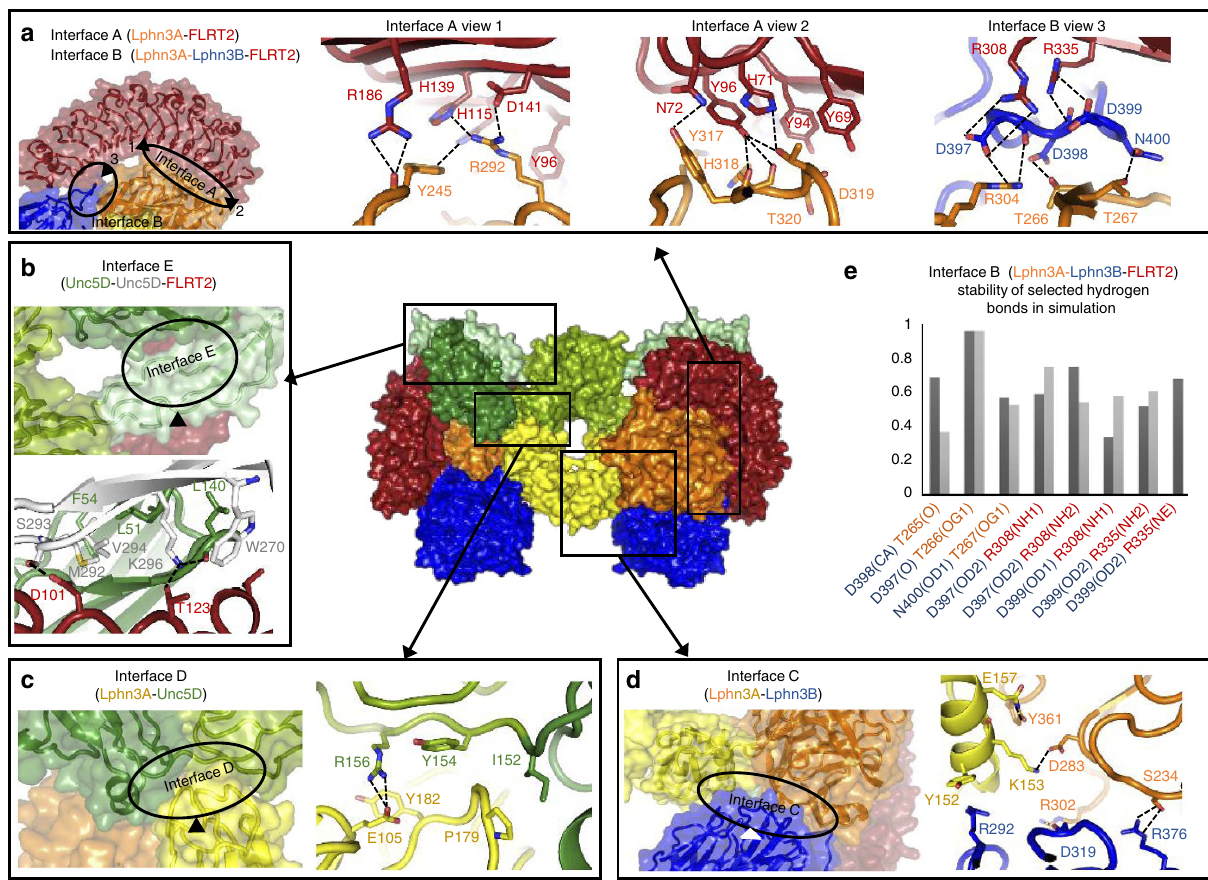
Figure 6 | Protein–protein interactions within the super-complex. ( a – d ) Novel protein–protein binding surfaces (interfaces A–E) in the FLRT2 LRR /Lphn3 Lec–Olf /Unc5D IgIgTSP complex are shown. Selected residues are shown as sticks. Selected putative hydrogen bonds are indicated as black dashed lines. ( e ) The stability of putative hydrogen bonds during molecular dynamics simulation is shown as the relative fraction of time they existed compared with the entire run time. The results are shown for interface B atoms within the two halves of the pseudo-symmetric complex (chains A–D: dark grey; chains E–F: light grey). Summaries of the main hydrogen bonding residues between the different protein chains are provided in Supplementary Table